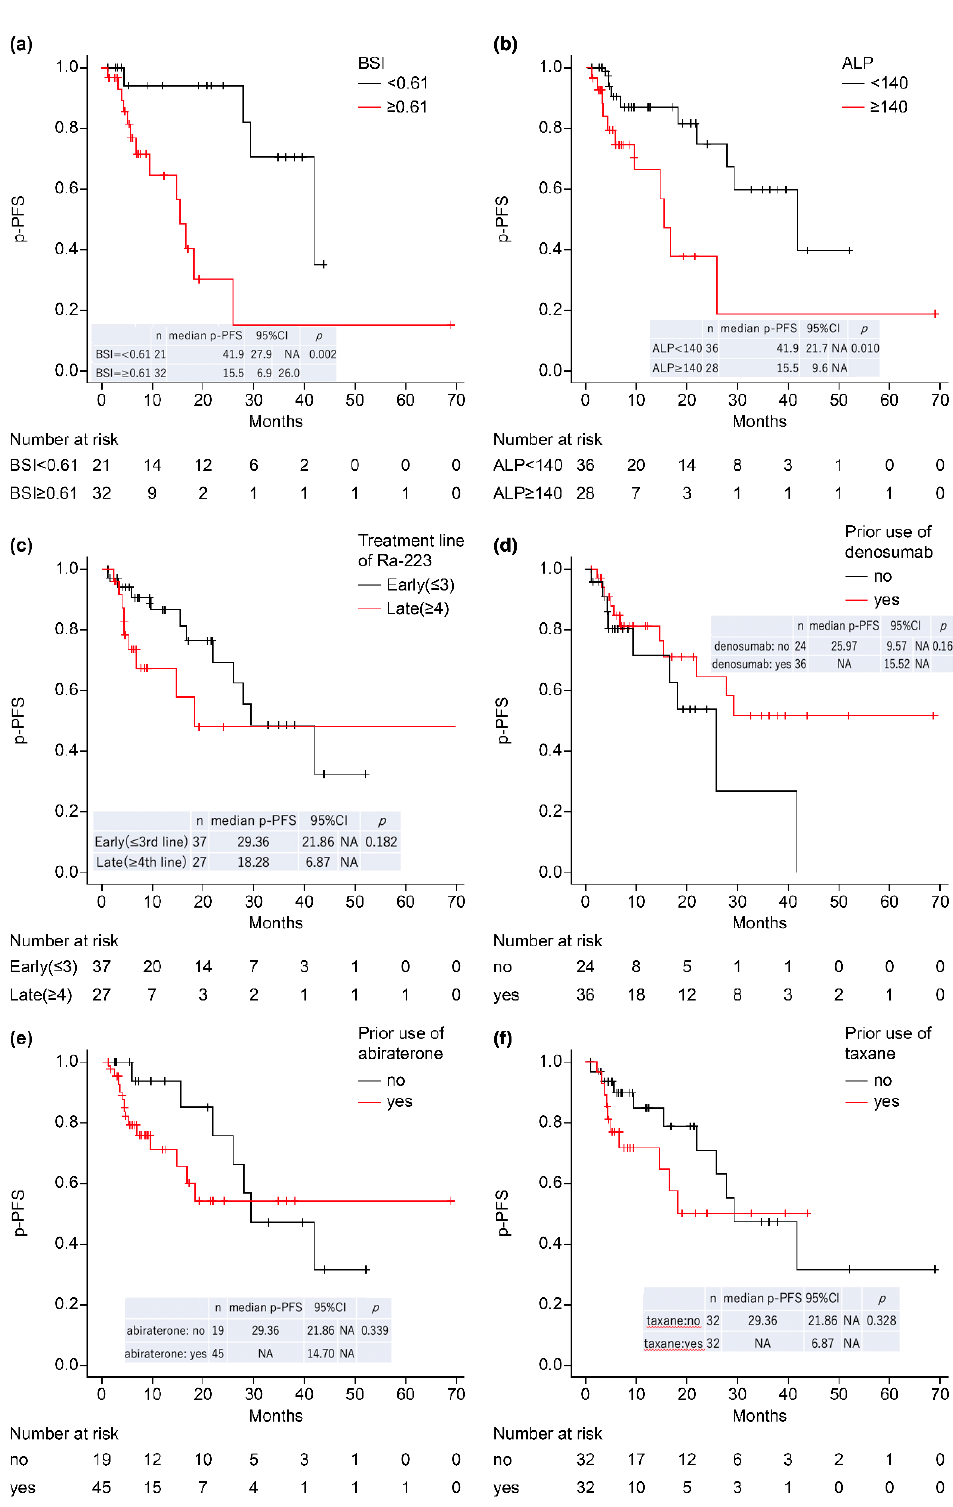
Figure 3. Log-rank test of p-PFS: ( a ) BSI < 0.61 vs. BSI ≥ 0.61; ( b ) ALP < 140 vs. ALP ≥ 140; ( c ) treatment line of Ra-223, Early ( ≤ 3) vs. Late (4 ≥ ); ( d ) prior use of denosumab, no vs. yes; ( e ) prior use of abiraterone, no vs. yes; ( f ) prior use of taxane, no vs. yes. Figure 3 ( c – f ) shows that p-PFS is prolonged in the early treatment group ( ≤ 3rd line) and in the prior use of denosumab group, while p-PFS is shortened in the prior use of abiraterone and taxane groups, although the differences are not significant. p-PFS: pain progression-free survival. NA: not available There was no significant difference in the p-PFS between patients with and without pain at the time of the first dose of Ra-223. Between ALP and ALP_rate, Spearman’s cor- relation coefficient was − 0.521. The median (range) NLR obtained from 48 cases were 3.05